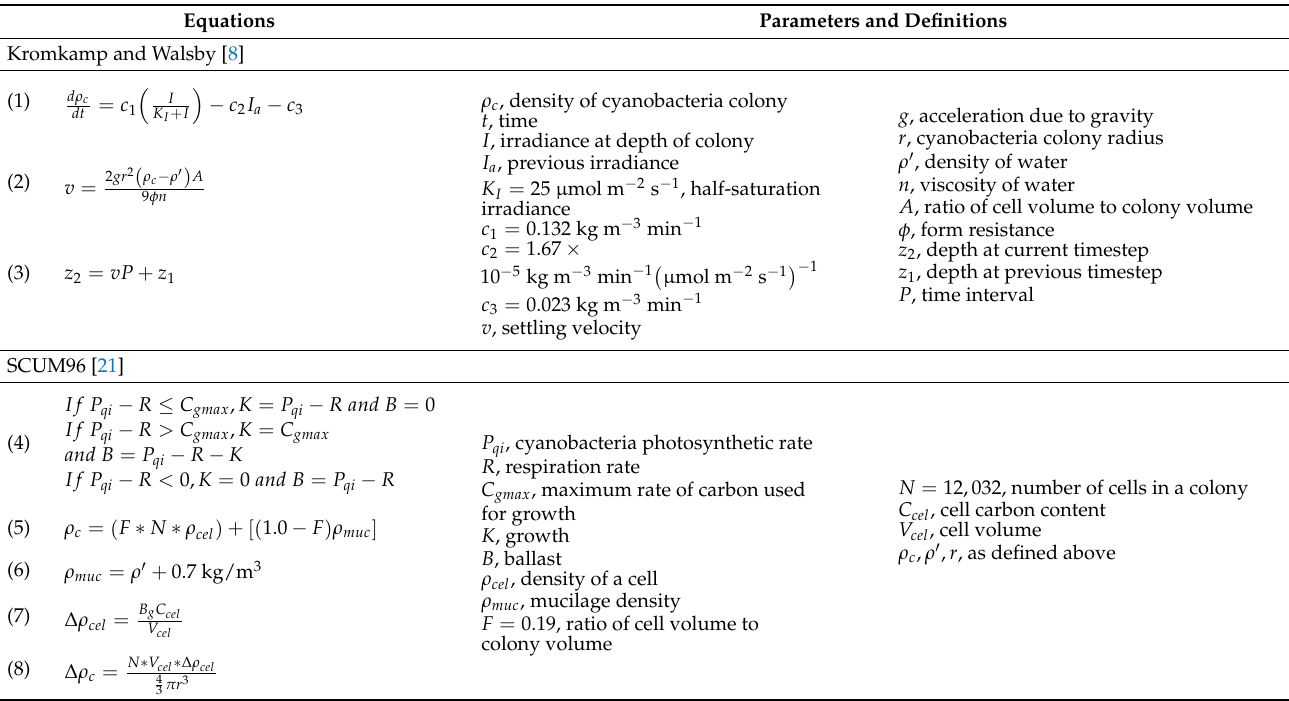
Table 1. Summary of vertical migration